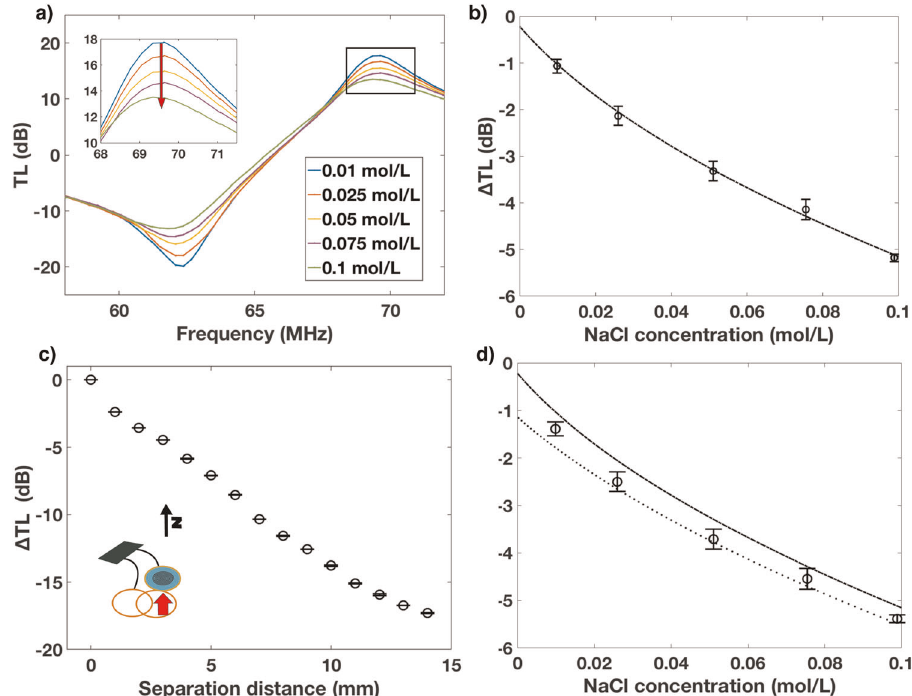
Fig. 3 Effect of conductivity on Δ TL. a Bode plot TL for frequency sweep of sticker fi lled with solutions with increasing (red arrow) concentration of NaCl. b Quadratic model of Δ TL as a function of solution conductivity for resonator directly on reader antenna. c Effect of separation distance between resonator and reader on Δ TL. d Circles, test data of different conductivity solutions through PPE with model from b ) (-.) and model with correction offset based off garment thickness(..); n > 20, error bars s.